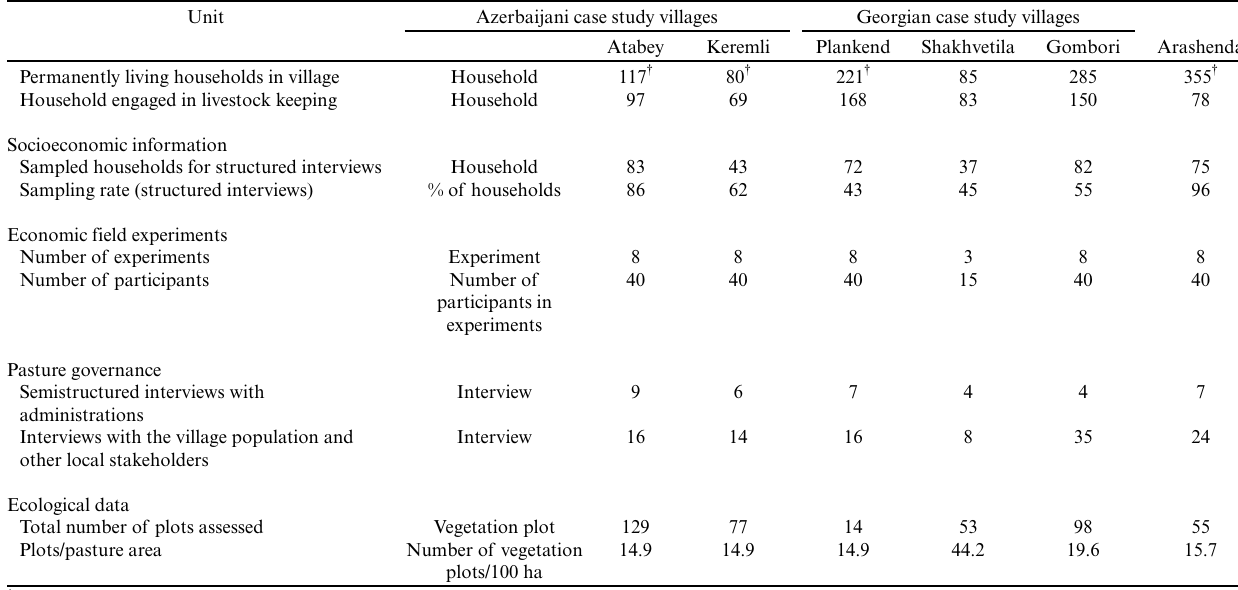
Table 2 . Data collection in the case study villages and on village pasture. Unit